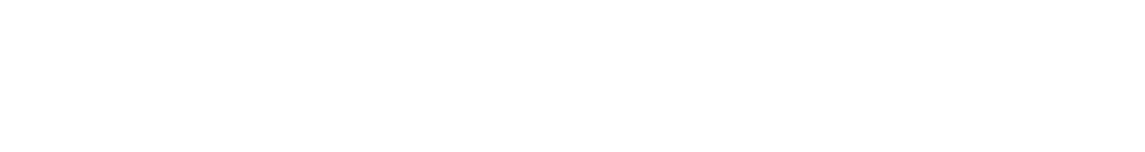
Frontiers in Cardiovascular Medicine |